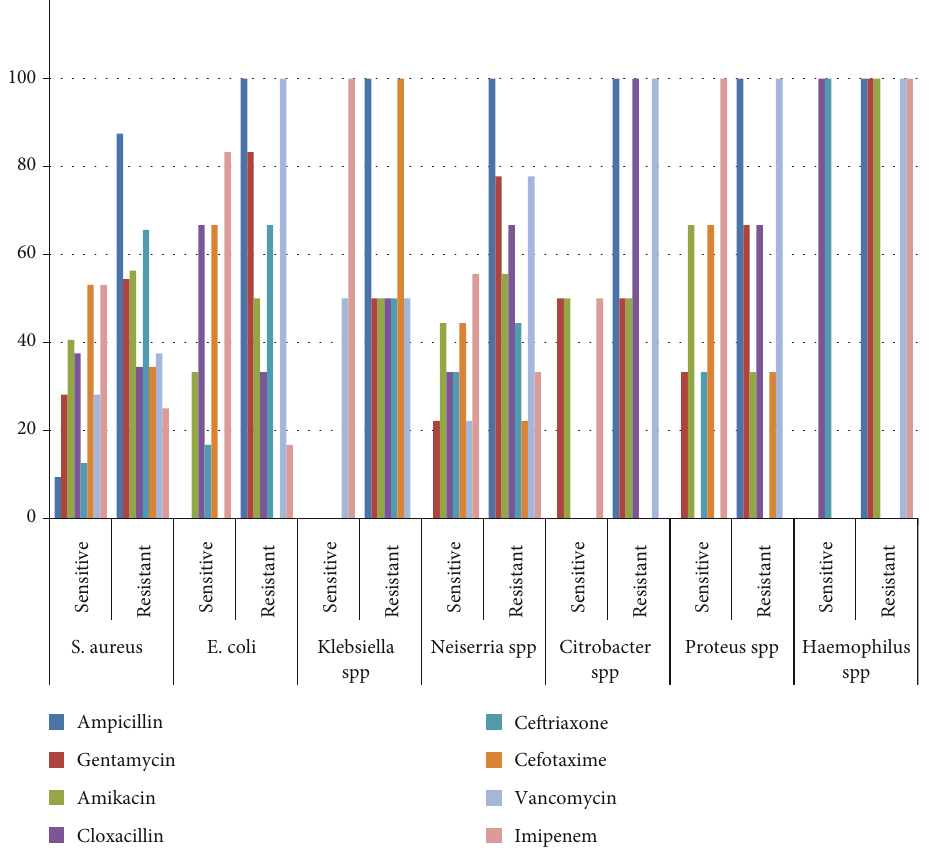
Figure 2: Percentage antibiotic sensitivity and resistance patterns of bacterial isolates from cord swabs among neonates diagnosed of